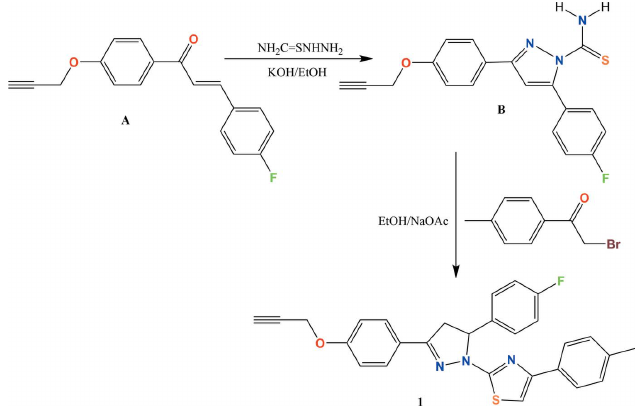
Figure 3 Reaction scheme for the synthesis of 5-(4-fluorophenyl)-1-[5-(4-methyl- phenyl)thiazol-2-yl]-3-[4-(prop-2-ynyloxy)phenyl]-4,5-dihydro-1 H -pyra- zole.